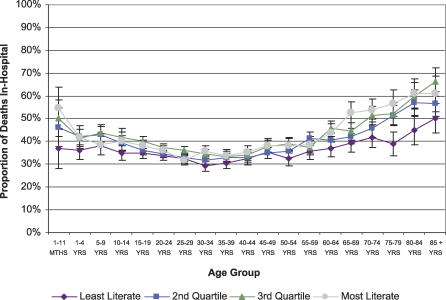
Proportion of Road Traffic Accident Deaths That Were in Hospitals, versus Age Group, According to Community Literacy Quartiles, Mexico 1998–2005Data are means and 95% confidence intervals.